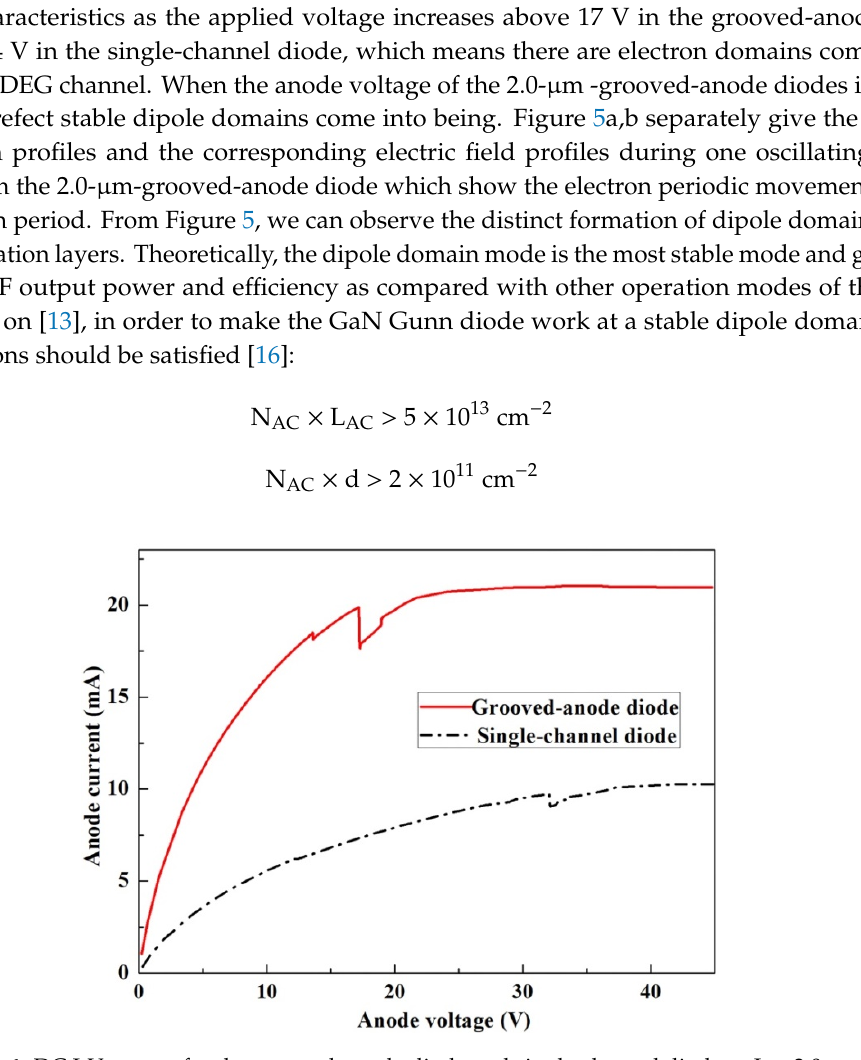
Figure 6. ( a ) Electron concentration and ( b ) Electric field profiles in one oscillation period in the grooved-anode diode as L = 1.2 µm. Meanwhile, if the channel length is too long, the electron domain grows to its mature size before reaching the anode contact. The remaining channel will be regarded as invalid growth space for the electron domain, which results in the decrease of the efficiency of the Gunn diode. The formation of the electron domain results in the current decline. When the electron domain grows to its full size, the current will drop to its lowest value. If L is too long, the lowest current will last for a period until the electron domain begins to disappear from the anode side. As shown in Figure 7, the lowest-value part of the current wave obviously extends as the channel length L increases, which aggravates the nonlinearity of the oscillation wave, and enhances the harmonic component of the oscillation wave. It is worth noting that two current peaks occur in the 3.6-µm diode, as shown in Figure 7. Figure 8 gives the electron movement tracks in the 3.6-µm diode, which shows that two dipole domains form simultaneously inside each channel; while one forms at near the cathode side, one forms near the middle of the channel. As the electron concentration of 2DEG is very high, therefore, the effective channel lengths for both nucleating points satisfy the condition of the dipole domain. The formation of two domains inside one oscillation circle also aggravates the nonlinearity of the oscillation wave, and weakens the fundamental frequency. In addition, as the two domains restrict each other, neither of them are able to grow to their full size. Therefore, the fundamental and harmonic components of both are reduced. Figure 9 gives the frequency spectrum diagram of the grooved-anode diode for different L from 1.2 to 3.6 µm, which demonstrates that the harmonic component enhances and fundamental component decreases with L. As a result, the noise performance deteriorates with L. In conclusion, in order to avoid the harmonic component enhancement and increase the fundamental component, suitable channel length is of great importance.